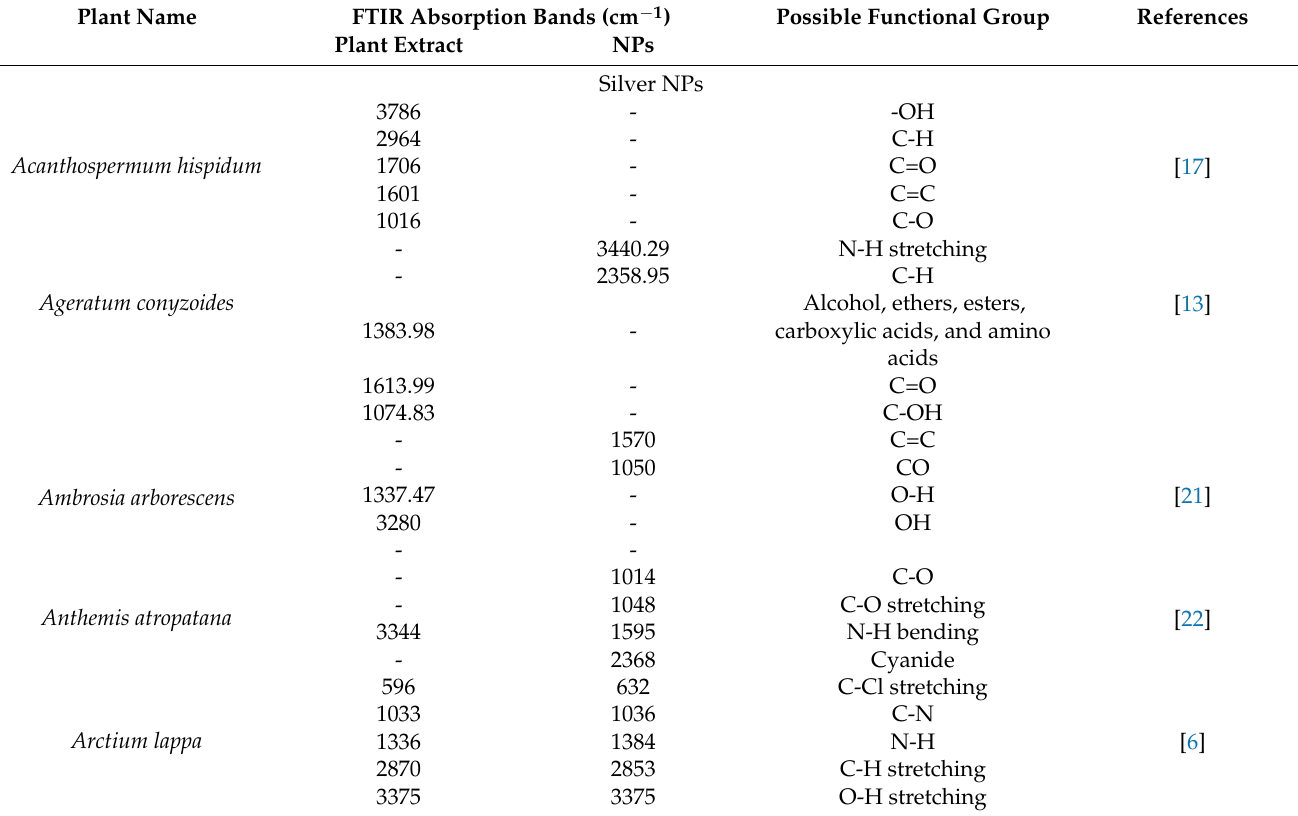
Table 3. Fourier transform infrared (FT-IR) spectra of the nanoparticles synthesized from Asteraceae